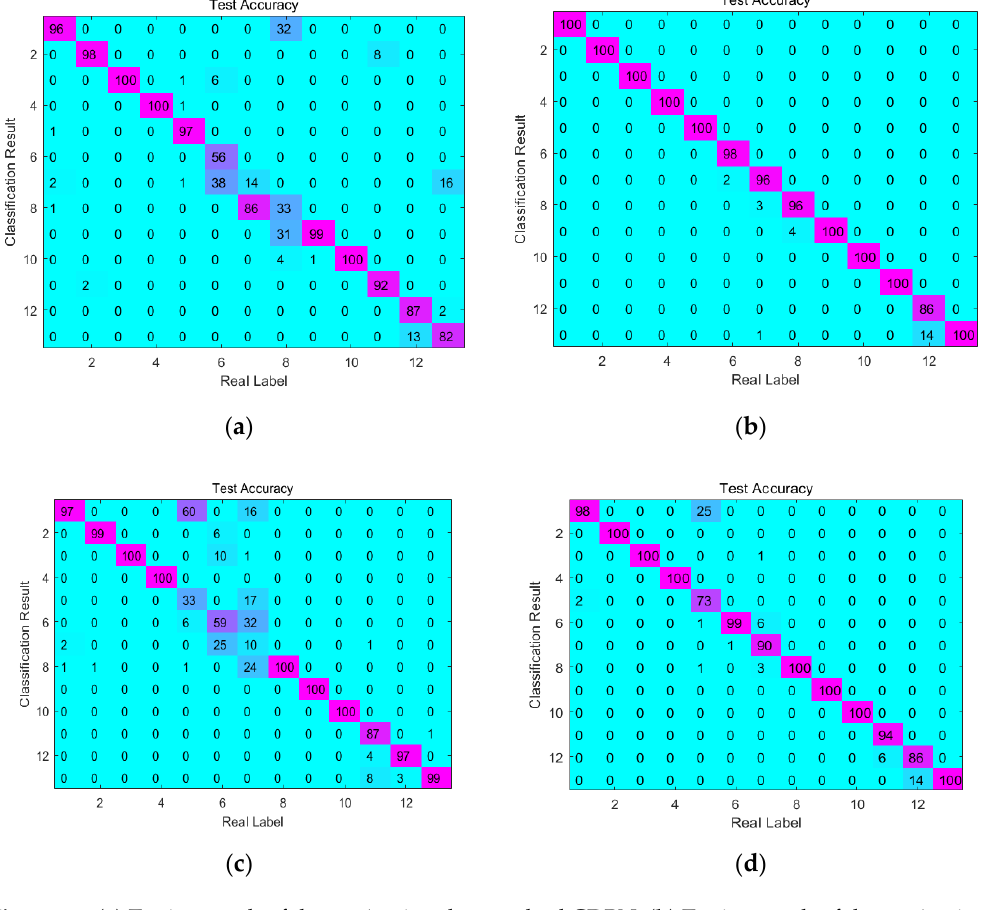
Figure 11. ( a ) Testing result of dataset1 using the standard CDBN. ( b ) Testing result of dataset1 using the improved CDBN. ( c ) Testing result of dataset2 using the standard CDBN. ( d ) Testing result of dataset2 using the improved CDBN.